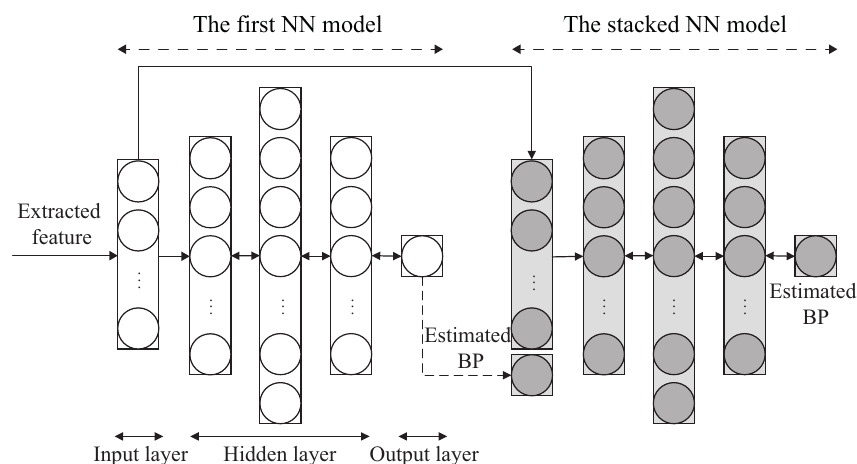
Figure 1. Block diagram of two-stage system based on the stacked NN.